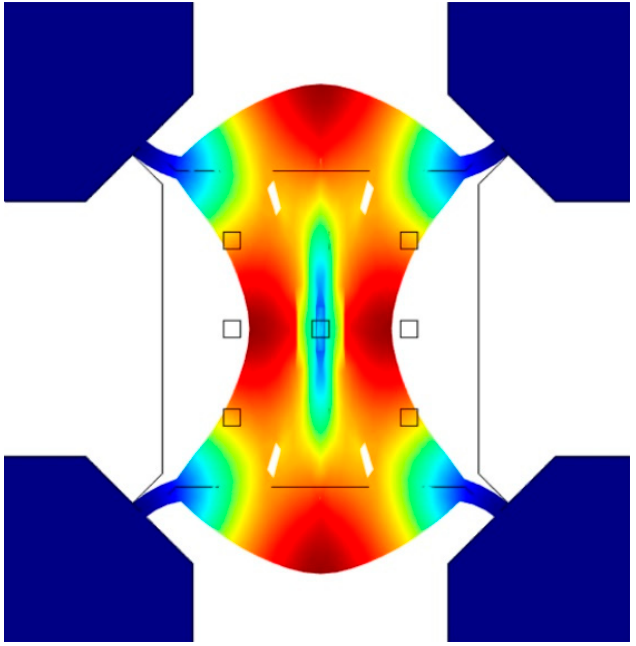
Figure 1. Simulated mode shapes of Lamé-mode resonator.